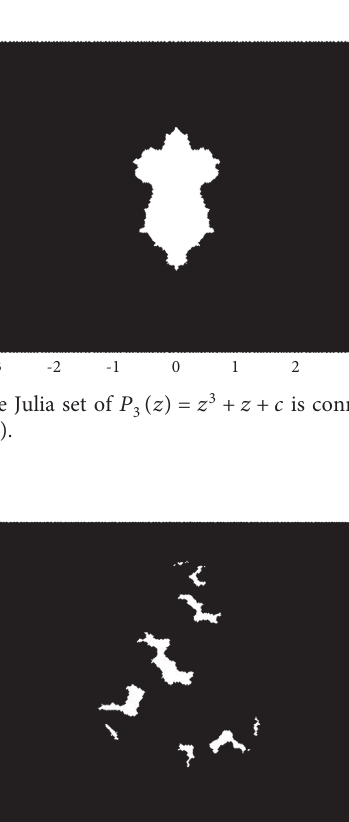
Figure 13: The Julia set of P 0.3+0.8i ∉ GM ( P